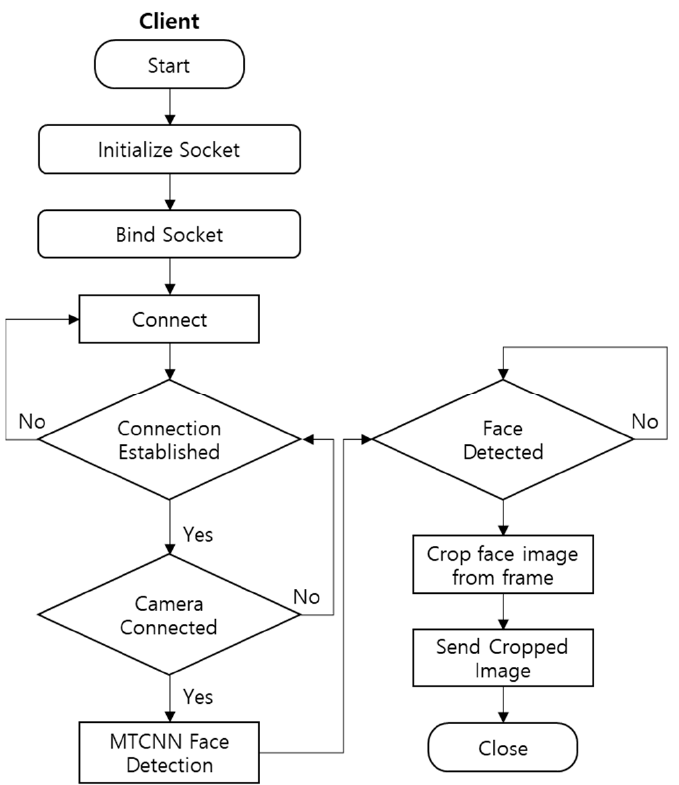
Figure 2. Edge-based face